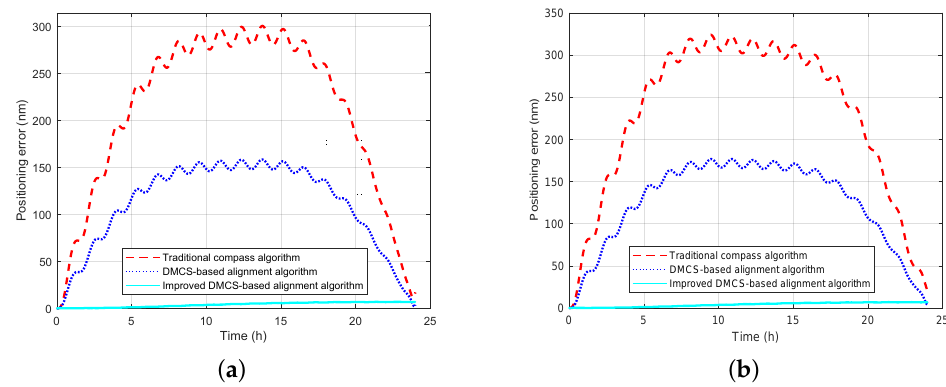
Figure 14. Positioning errors by utilizing the three initial alignment algorithms. The red dashed line denotes the positioning error curve by utilizing the traditional compass algorithm under the static base; the blue dotted line denotes the positioning error by utilizing the DMCS alignment algorithm under the single-axis rotating base; the light blue solid line denotes the positioning error by utilizing the improved DMCS-based alignment algorithm under the rotating base. ( a ) Positioning error when the initial heading error is 125 ◦ . ( b ) Positioning error when the initial heading error is − 170 ◦